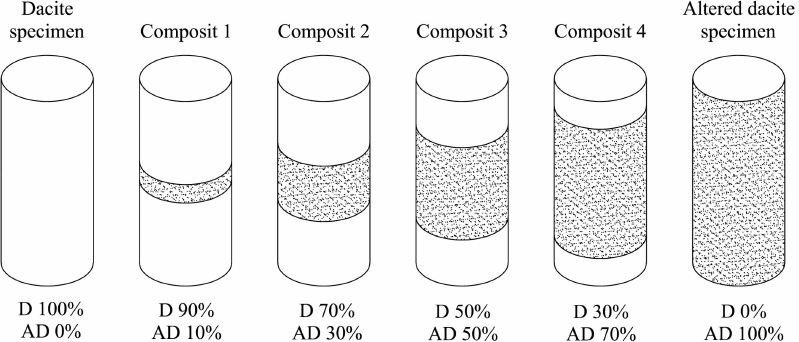
Figure 4. Scheme of tested samples